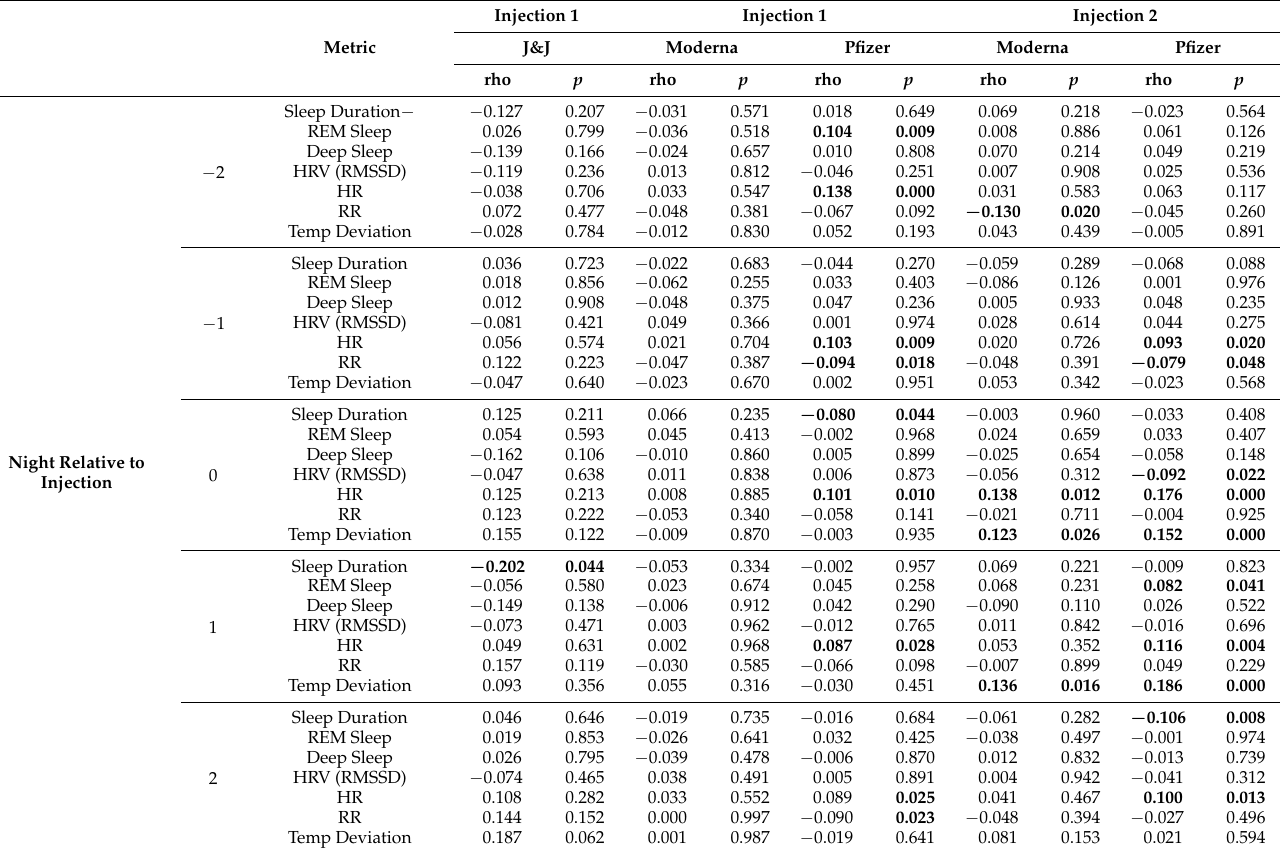
Table 2. Spearman rank-order correlations between RBD antibody responses and device-generated metrics on nights before and after each vaccine